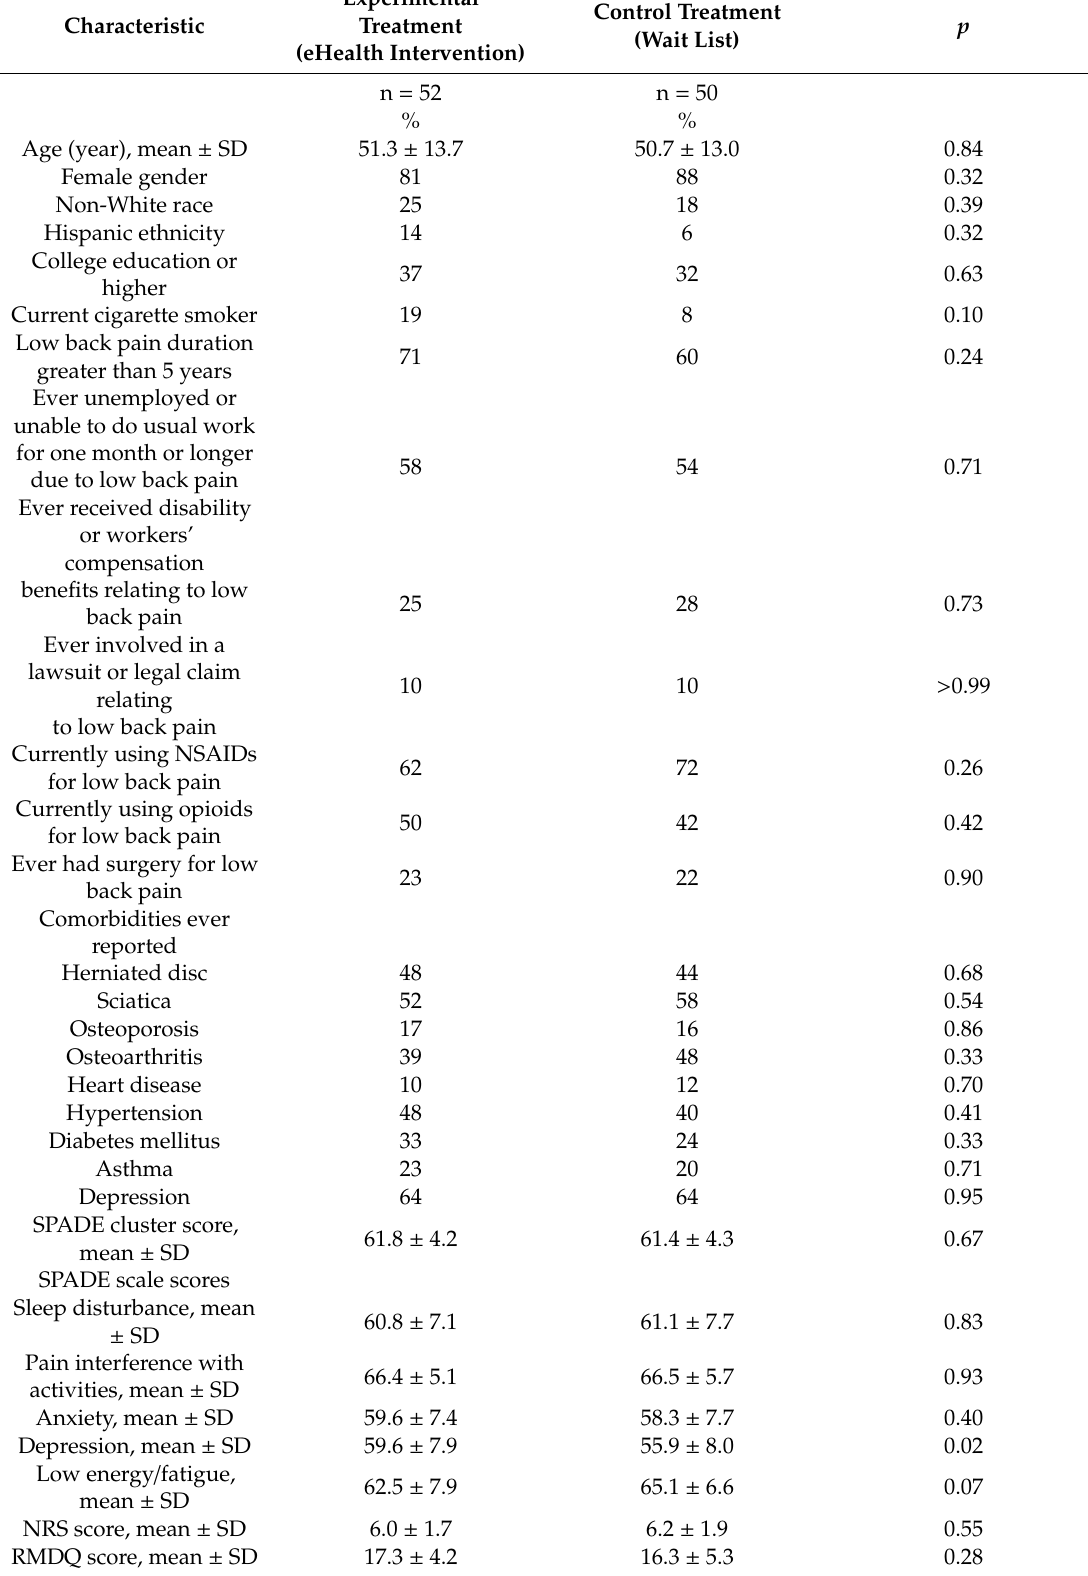
Table 1. Sociodemographic and clinical characteristics of the patients at baseline according to treatment group ( N = 102)